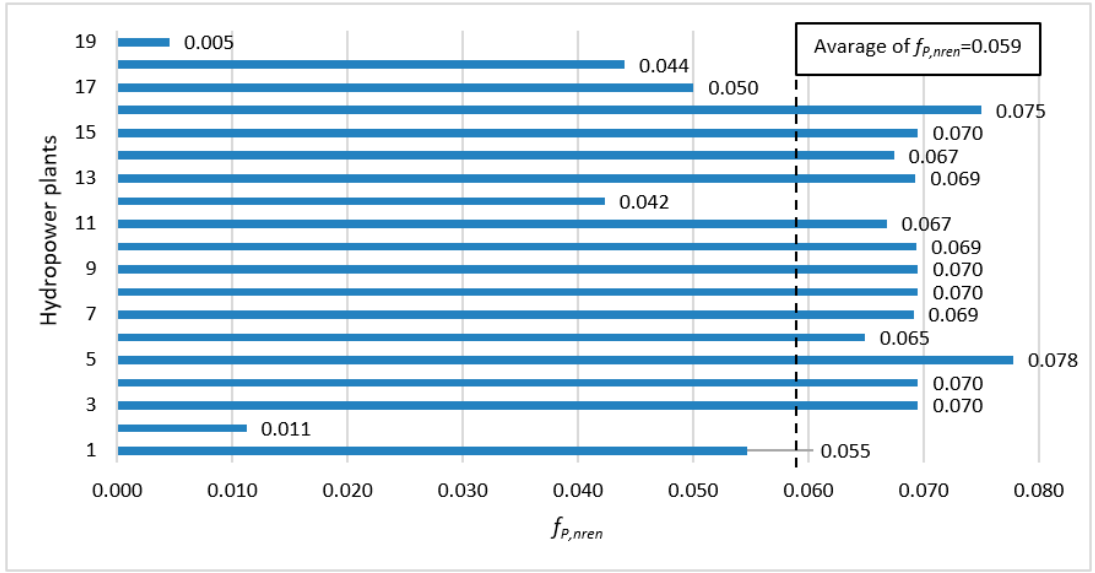
Figure 1. Average annual values of f P,nren of hydropower plants in